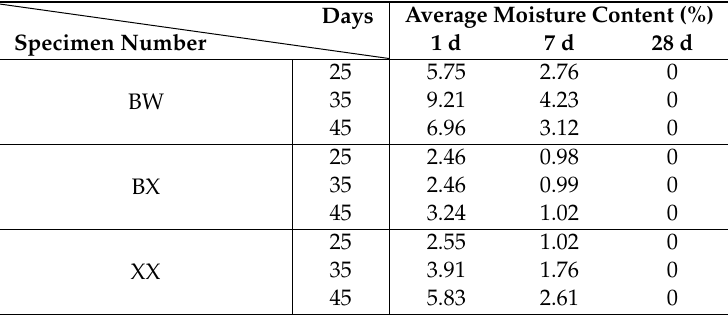
Table 9. Moisture measurement data table.